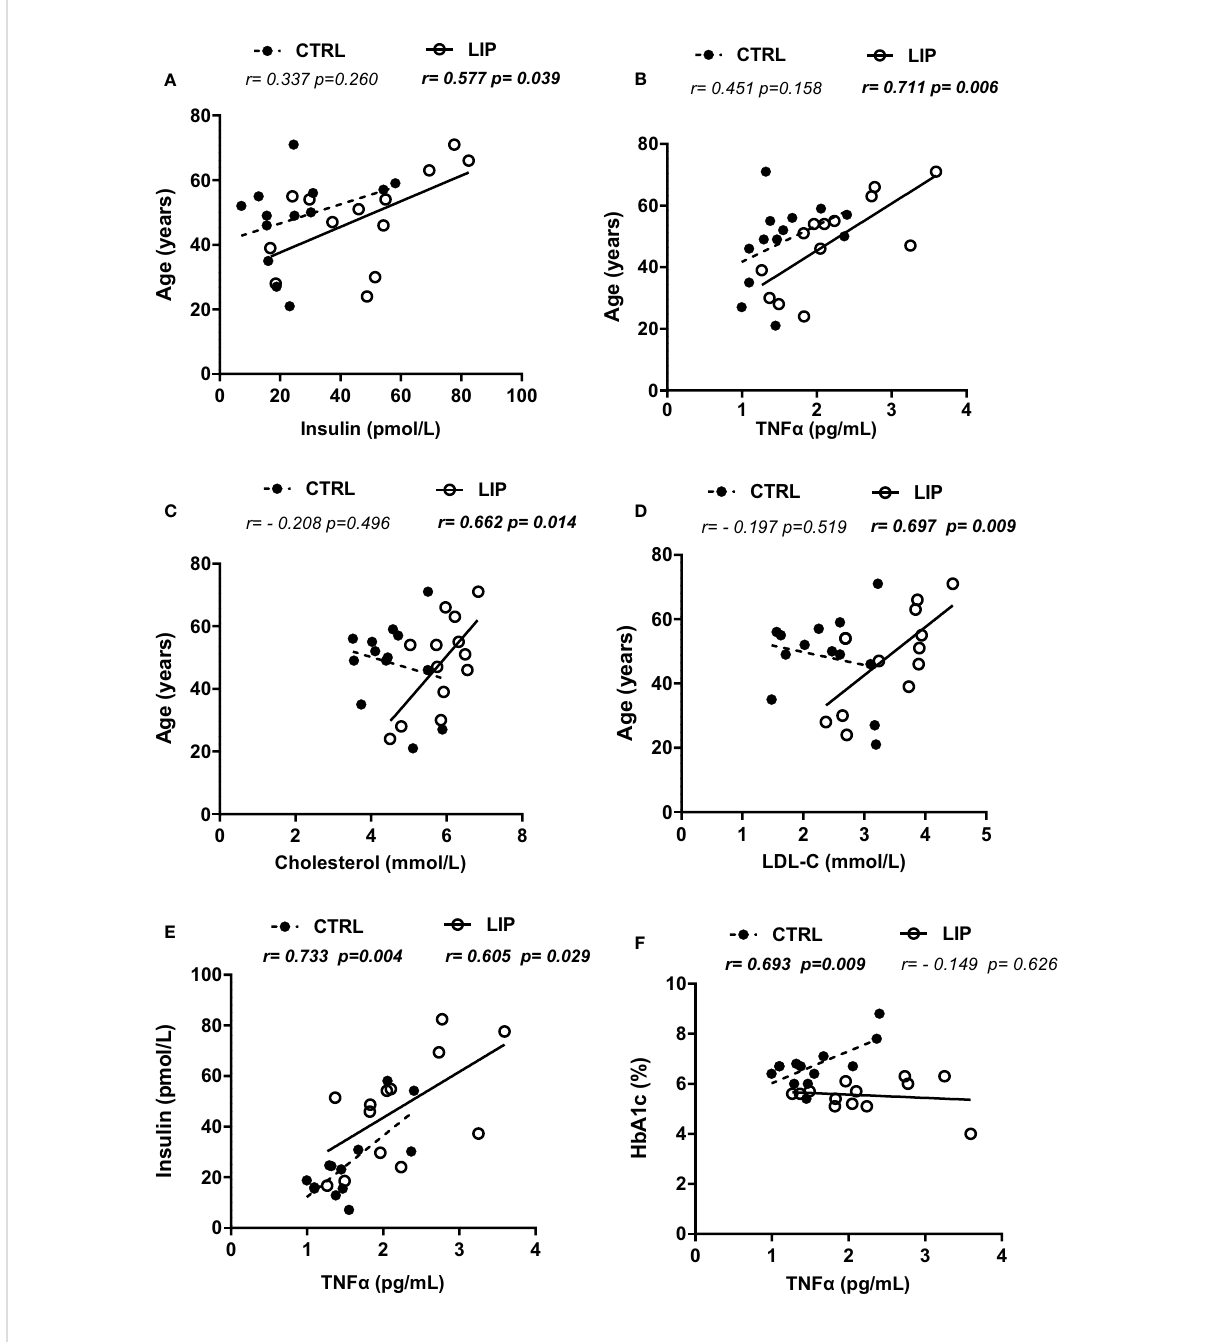
FIGURE 1 Correlations between biochemical markers and metabolic parameters in lipedema and control groups. (A – D) : association between age and circulating concentrations of insulin, TNF a , total cholesterol and LDL-C respectively; (E) : correlation between plasma insulin and TNF a levels; (F) : correlation between HbA1c percentage and TNF a plasma levels. r coef fi cients and p values are from Pearson ’ s pairwise correlations; HbA1c, Hemoglobin A1c; LDL-C, Low-density lipoprotein cholesterol; TNF a , Tumour Necrosis Factor-alpha; CTRL, Control group; LIP, Lipedema